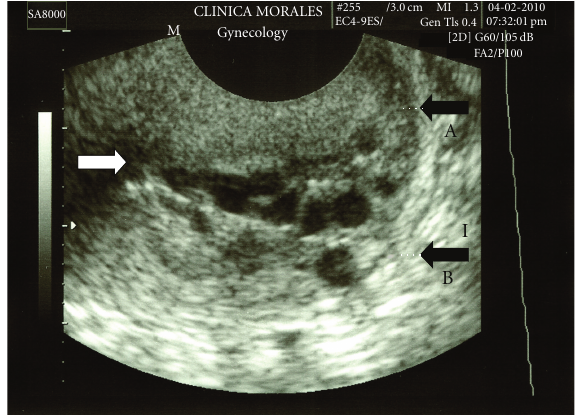
Figure 2: Transvaginal ultrasound depicts an axial section of the uterus; a normal anteroflexed uterus is seen with a double cervix (black arrows A, B). Both endocervical channels join together. White arrow points to the place at the internal cervical os where the channels